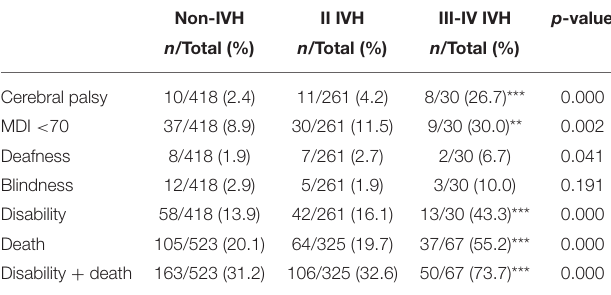
TABLE 2 | Unadjusted neurodevelopmental outcomes and death at 18–24 months of corrected